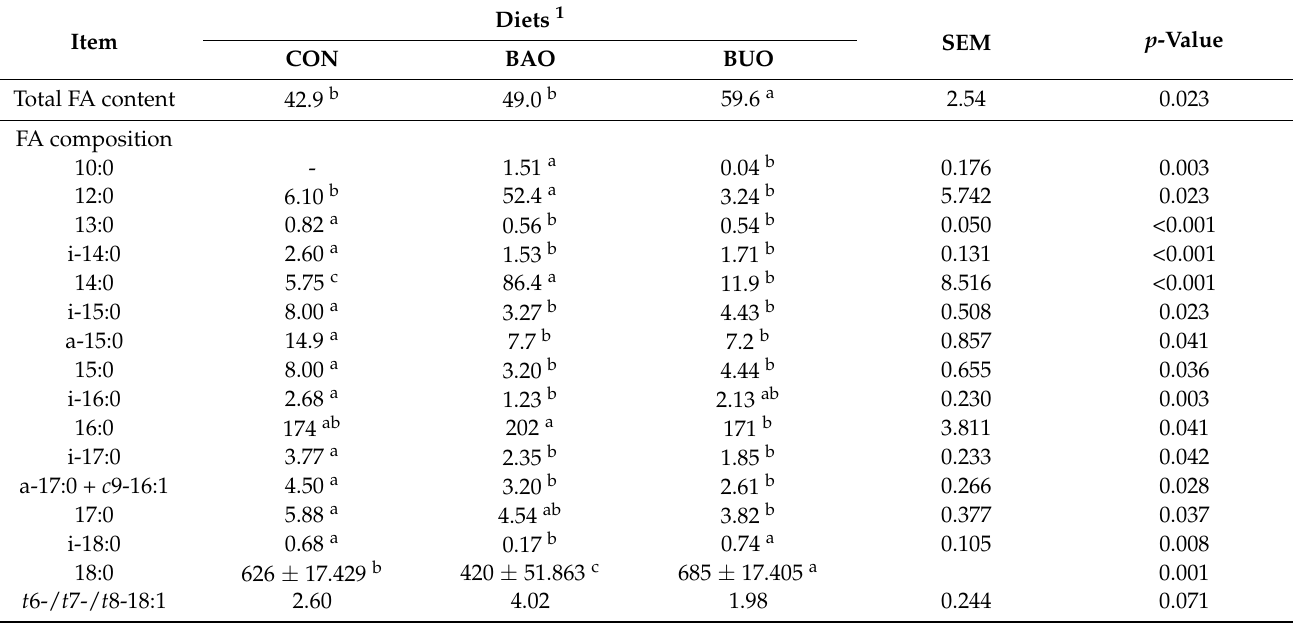
Table 5. Total fatty acid (FA) content (mg/g DM) and composition (g/kg total FA) of the abomasal content of sheep fed diets containing babassu or buriti